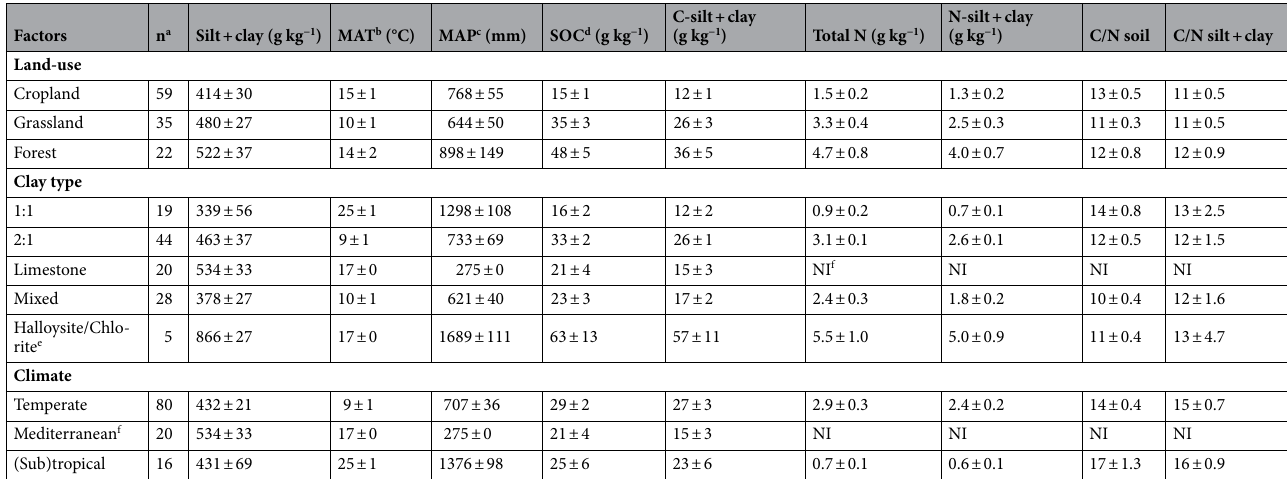
Table 2. Soil characteristics from 17 studies published results of 116 bulk soil and fine particle size < 20 µm (± standard error of the mean). Leinweber and Reuter 47 ; Mc Keague 48 ; Schulten and Leinweber 6 ; Turchenek and Oades 53 ; Schmidt et al. 54 ; Balabane and Plante 55 ; Christensen 56 ; Christensen 57 ; Christensen and Christensen 58 ; Chehire et al. 59 ; Guggenberger et al. 60 ; Bonde et al. 61 ; Balesdent et al. 62 ; Chichester 63 ; Oades and and Waters 64 ; Oorts et al. 65 ; Caravaca and Albaladejo 66 ; Asano and Wagai 67 ; Solomon et al. 68 ; Solomon et al. 69 ; Almelung et al. 70 ; Feller et al. 71 . a Soil N was obtained from 69 bulk soil and 68 particle size fractions. b Mean annual temperature. c Mean annual precipitation. d Soil organic carbon. e Include volcanic materials. f Not